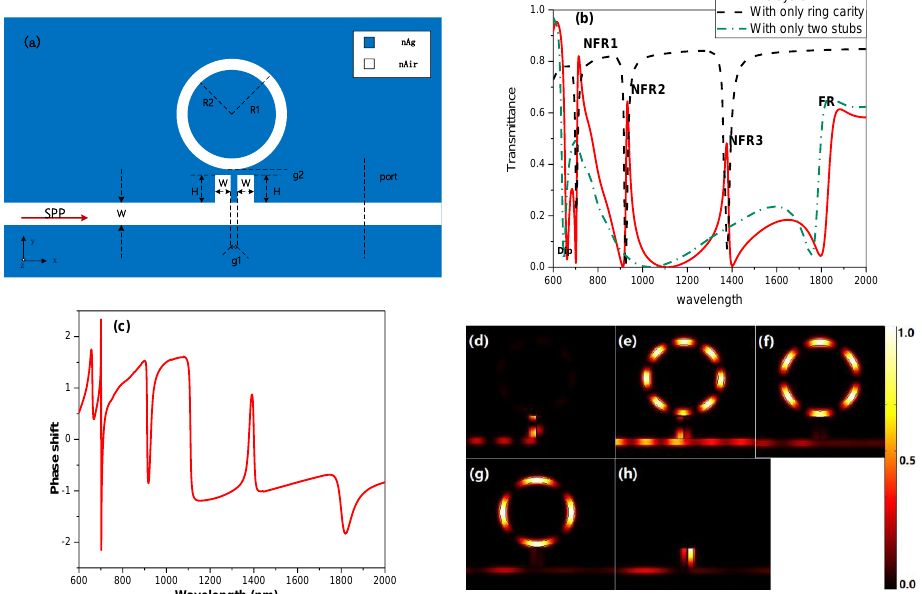
Figure 4. ( a ) The schematic diagram of the structure added a ring cavity on the two stubs. ( b ) The transmittance spectra of the extend model with H = 200 nm, g1 = g2 = 10 nm, R1 = 290 nm and R2 = 340 nm (the red solid line), the MIM waveguide with a ring cavity (the black dash line) and the MIM waveguide with two stubs (the green dash-dot line). ( c ) The phase shift spectrum of the extended structure. ( d–g ) The normalized field intensity distribution ( |𝐻 𝑍 | 2 ) at λ = 662 nm (d), λ = 714 nm (e), λ = 932 nm (f), λ = 1376 nm (g) and λ = 1882 nm (h).